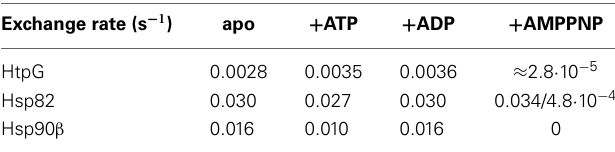
Table 1 | Subunit exchange rates of Hsp90